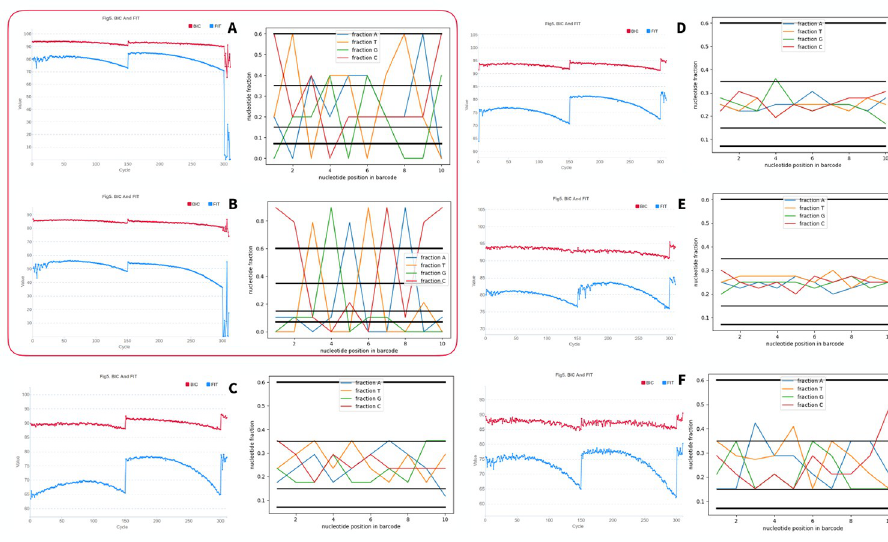
Fig 14. FIT graphs and BC-store results for analyzing barcode sets for unsuccessful (A, B) and successful (C-F) launches in our laboratory in PE150 mode on MGISEQ-2000. The quantity for analysis and comparison can be the amount of undecoded data. Undecoded data means the procent of data with barcode that cannot be accurately identified. Such bad data cannot be used in furthesr research.